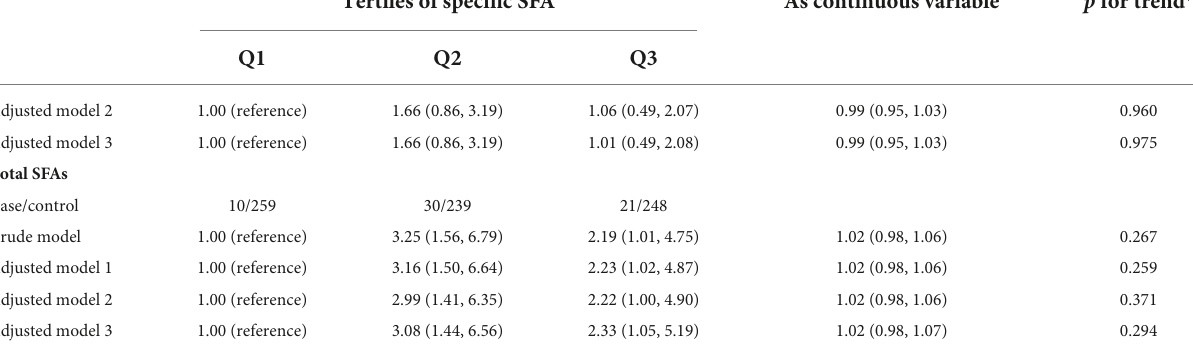
Frontiers in Nutrition